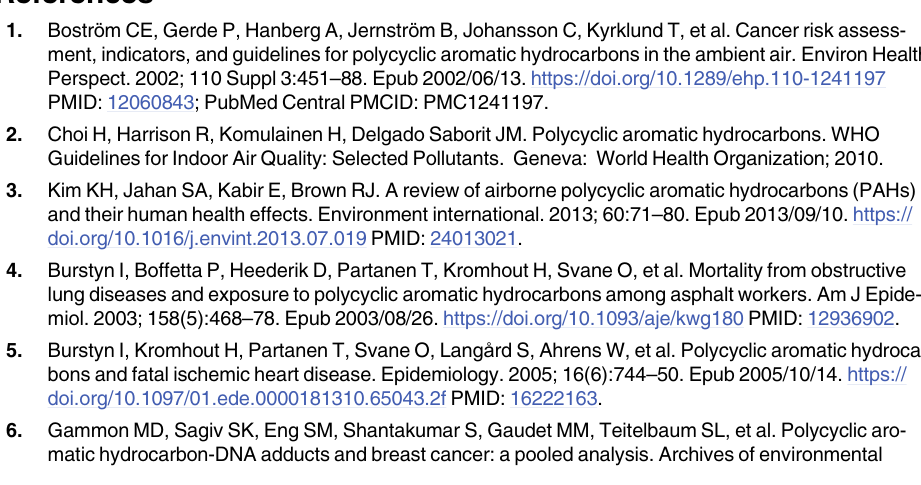
S4 Table. Associations between creatinine-corrected S OH-PAHs (nmol/g Cre) and mor- tality, including urinary creatinine (g/L) as an additional covariate. S5 Table. Continuous final models of S OH-PAHs and all-cause and cause-specific mortal- ity, not excluding self-reported history of cancer or CVD at baseline. S6 Table. Multipollutant models examining the association between individual OH-PAHs and all-cause, cancer-specific, and CVD-specific